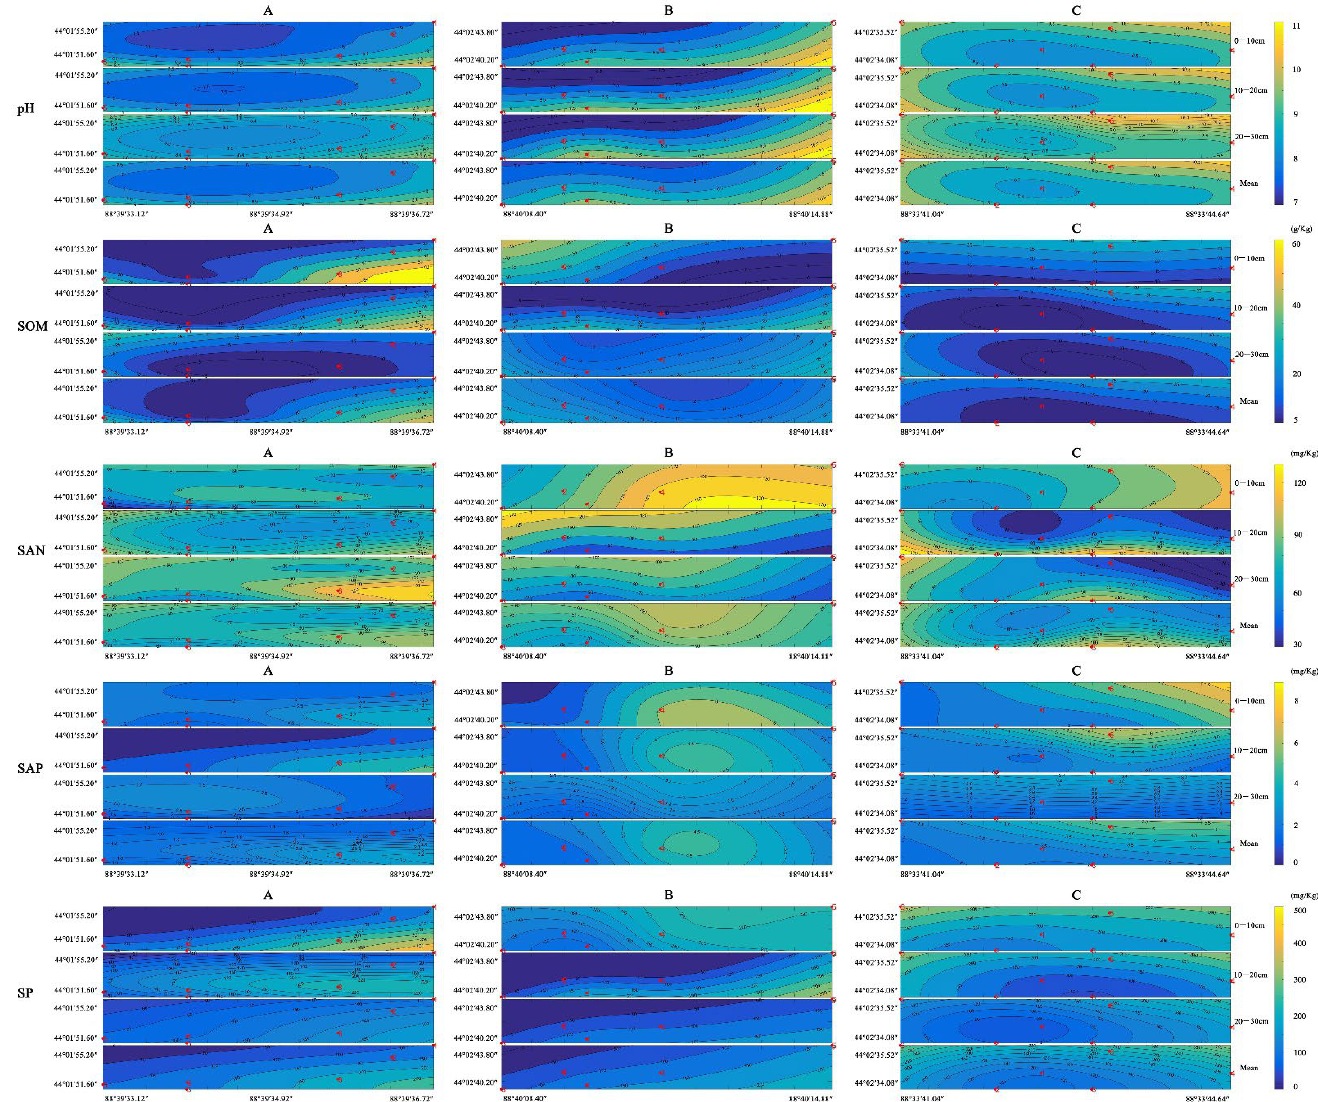
Figure 3. Spatial distribution of the physical and chemical properties of the soil.